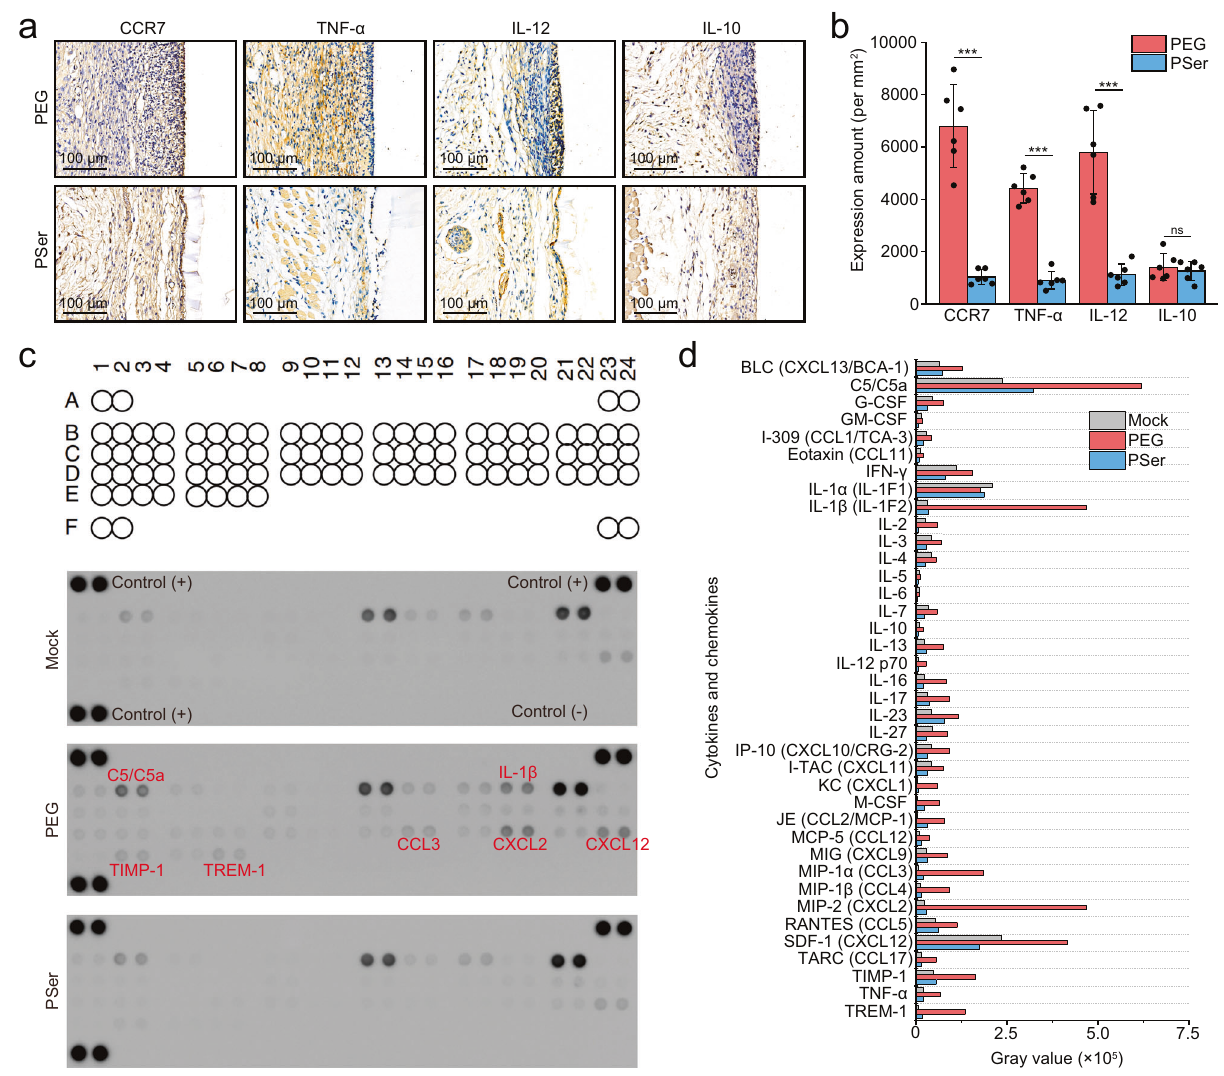
Fig. 5 In fl ammatory marker staining and cytokine pro fi ling analysis 2 weeks post implantation. a Immunohistochemical staining of in fl ammatory markers (CCR7, TNF- α , IL-12, and IL-10) in tissues surrounding PEG2000 and PSer3300 hydrogels. Cells stained by in fl ammatory markers show brown color, while all nucleus stained with hematoxylin show blue color. b Quanti fi cation of in fl ammatory marker expression. Data were collected in the tissue within 100 µ m from the tissue-hydrogel interface. n = 6 (six mice for each type of hydrogel), mean values ± s.d. c Cytokine pro fi ling for tissue lysates 2 weeks post-implantation of PEG2000 and PSer3300 hydrogels, using Mock group without implantation as control. The mouse cytokine array coordinates are shown in Supplementary Table 4. d Gray values of cytokine and chemokine expression. Statistical analysis: two-tailed t -test, ** p < 0.001, ns: not signi fi